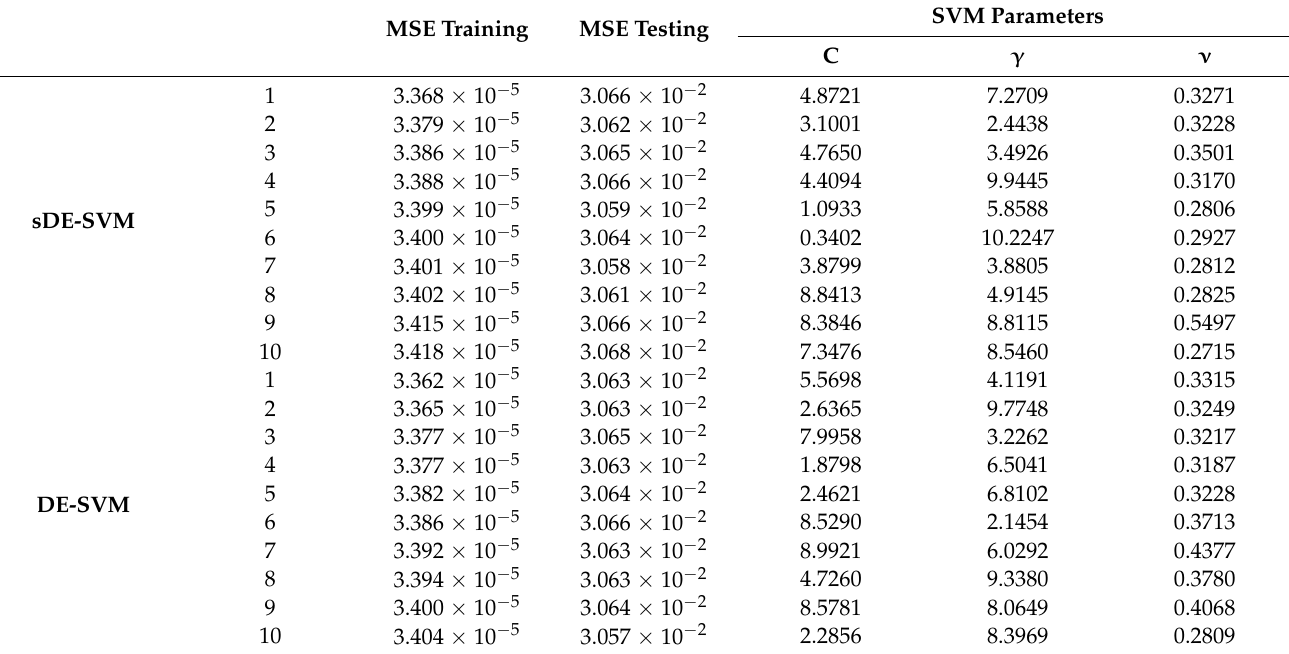
Table 2. Results for the regression approach based on sDE-SVM and